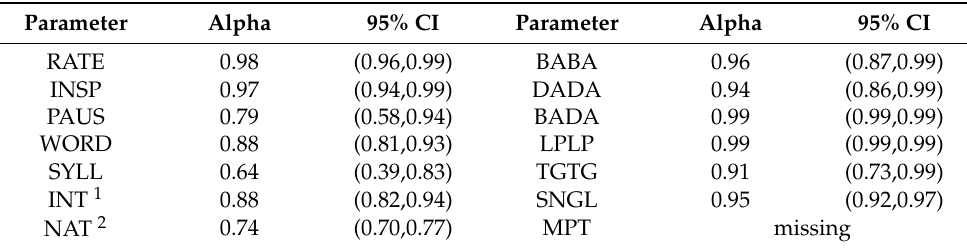
Table 3. Examiner agreements for all diagnostic parameters. Krippendorff’s alpha across 60 partici- pants (48 patients, 12 controls) and two raters per sample. Reliability analyses for INT and NAT were based on data from listener cohorts consisting of laypersons (see